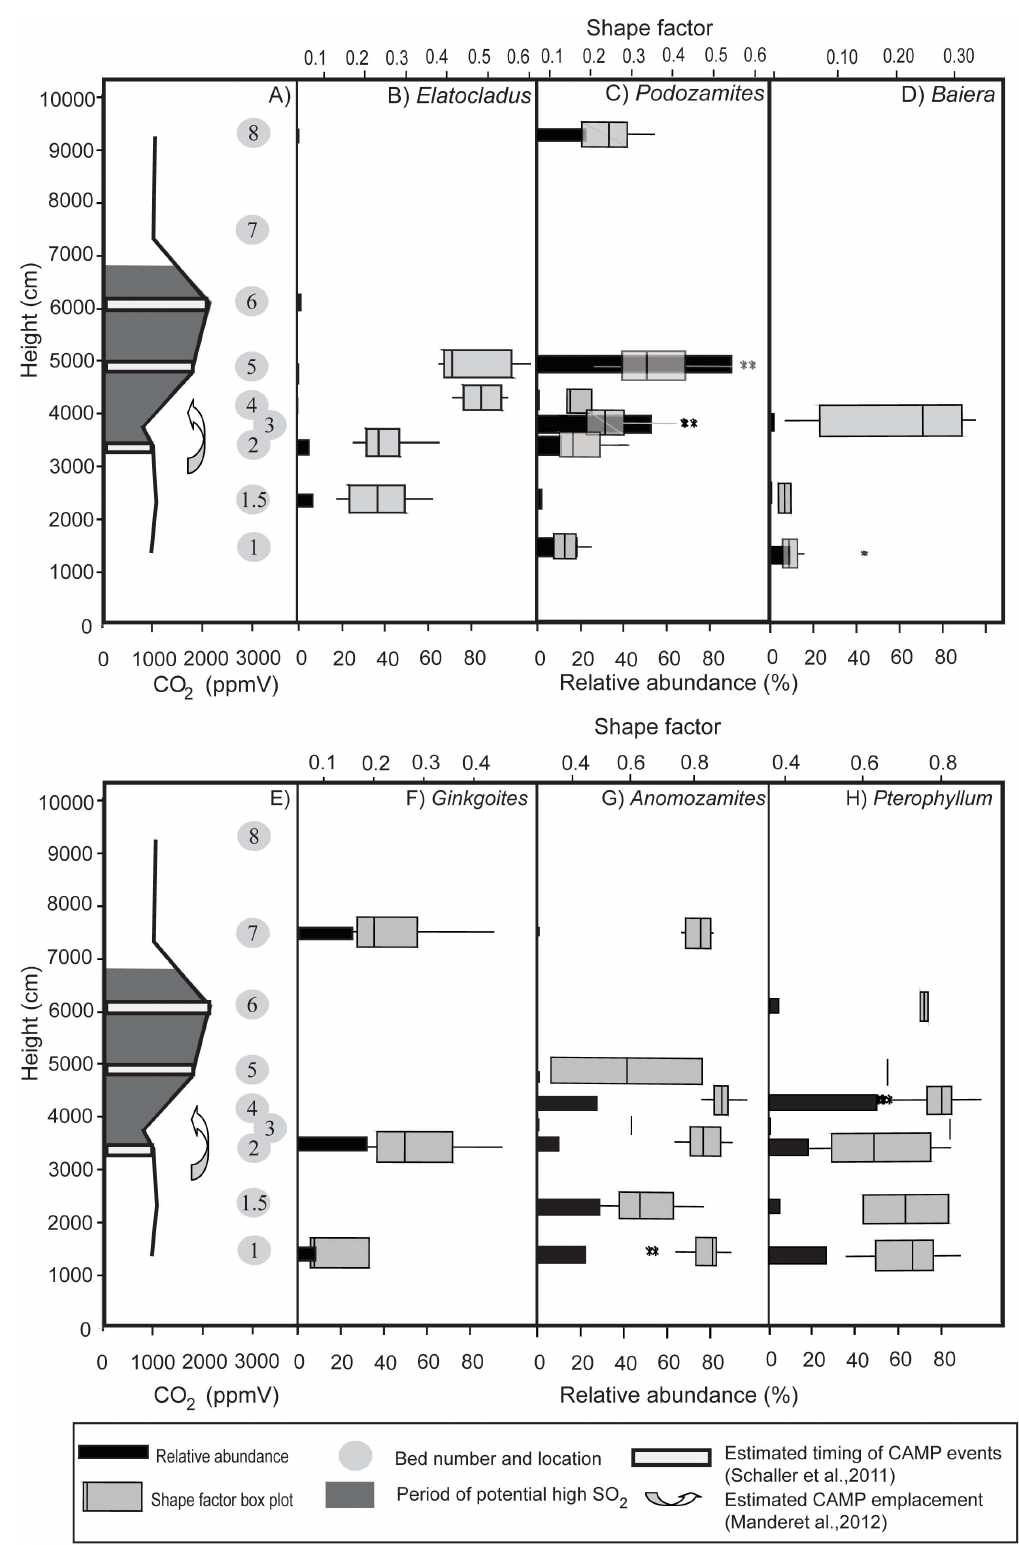
Figure 4. Comparison of atmospheric CO 2 changes and timing of potential high SO 2 with measured changes to fossil leaf relative abundance and shape factor at Astartekløft. Atmospheric CO 2 changes at Astartekløft [4] with the time of suggested likely high SO 2 [3;34] superimposed as grey (A) compared to shape factor changes as box plots and relative abundance changes as bars for each of the measured fossil taxa Elatocladus (B); Podozamites (C); Baiera (D); Ginkgoites (E); Anomozamites (F); Pterophyllum (G).